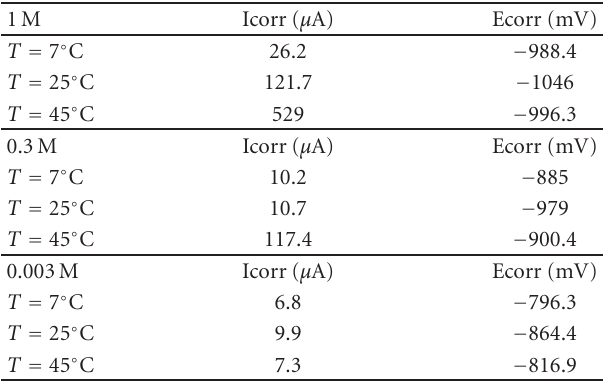
Figure 6: Cross section of the corroded Zn-10 Al-1.5 Cu alloy. Table 1: Comparison table between the three di ff erent